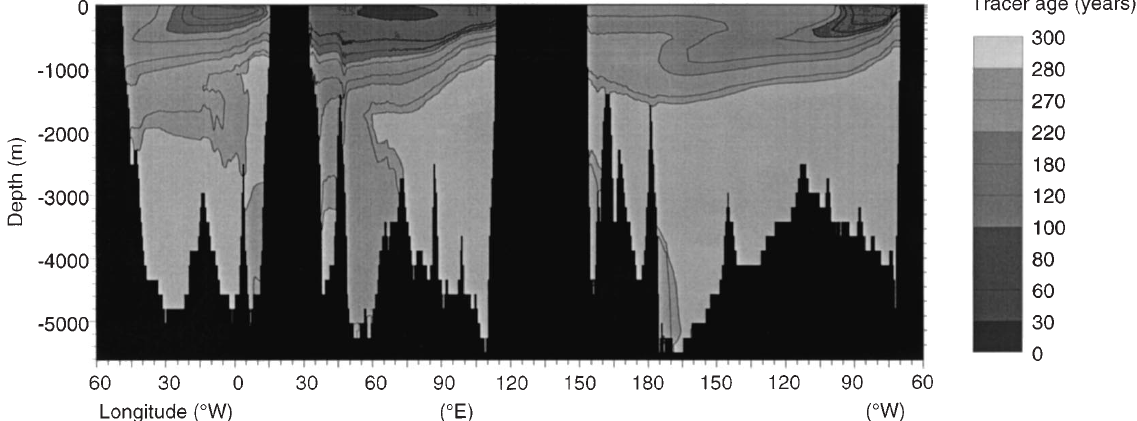
Fig. 7. A zonal section at 27 (cid:14) S circling the globe illustrating the age of tracer introduced at the Drake Passage (71 (cid:14) W). Land masses include South Africa (25 (cid:14) E), Australia (135 (cid:14) E) and South America (60